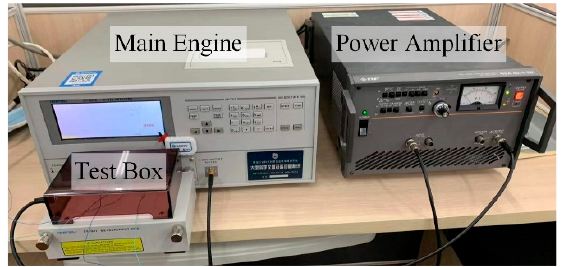
Figure 1. Material measurement device in room-temperature environment.